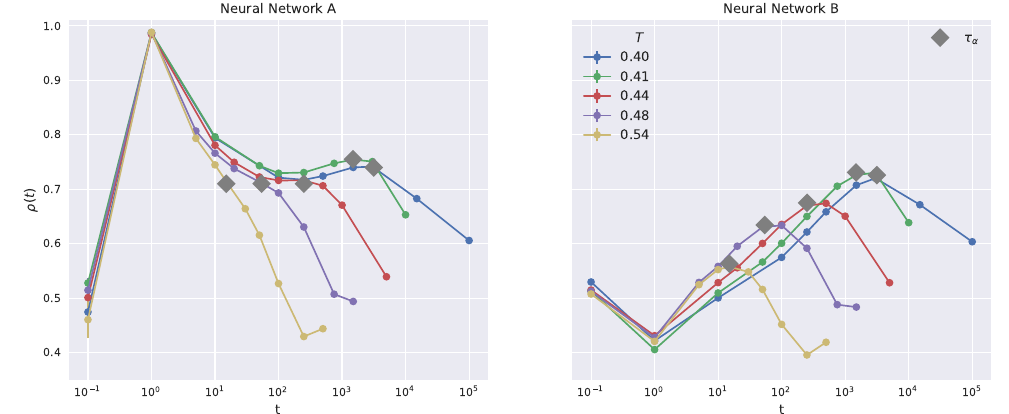
Figure 4. Pearson correlation coefficient of the propensity prediction for all the investigated state point with Neural Network A ( left panel) and B ( right panel). Gray diamonds mark the position of the structural relaxation time of the given state